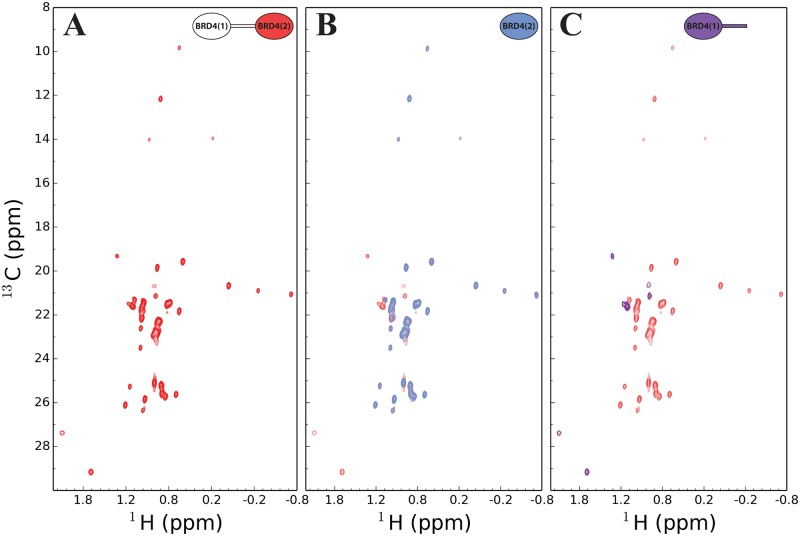
Methyl-TROSY of segmentally labelled BRD4(1, 2).(A) 1H-13C SOFAST TROSY HMQC of segmentally labelled BRD4(1, 2) with U-[2H,15N] and 13CH3 ILV methyl labelled BRD4C (red). (B) Spectral overlay of (A) with isolated U-[2H,15N] and 13CH3 ILV methyl labelled BRD4C (blue). (C) Spectral overlay of (A) with natural abundance BRD4NL (purple).